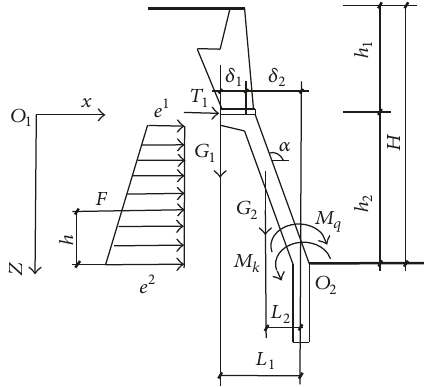
Figure 3: Sketch map of self-balancing retaining wall stress analysis.